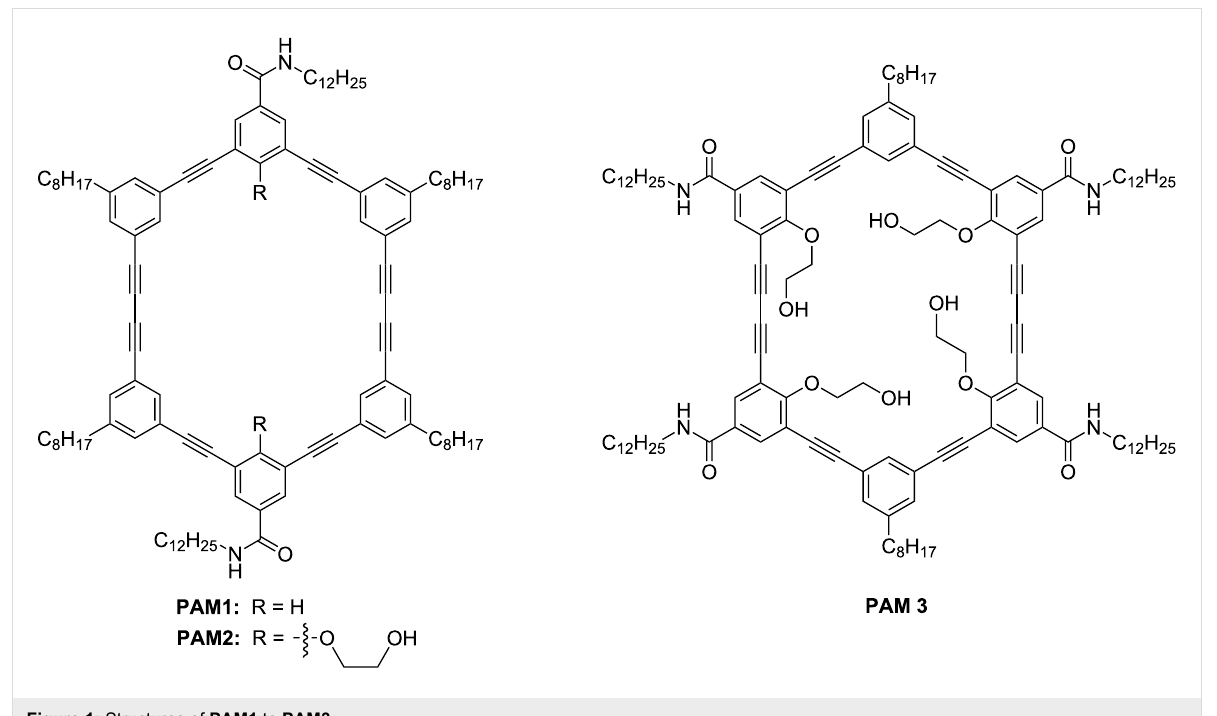
Figure 1: Structures of PAM1 to PAM3